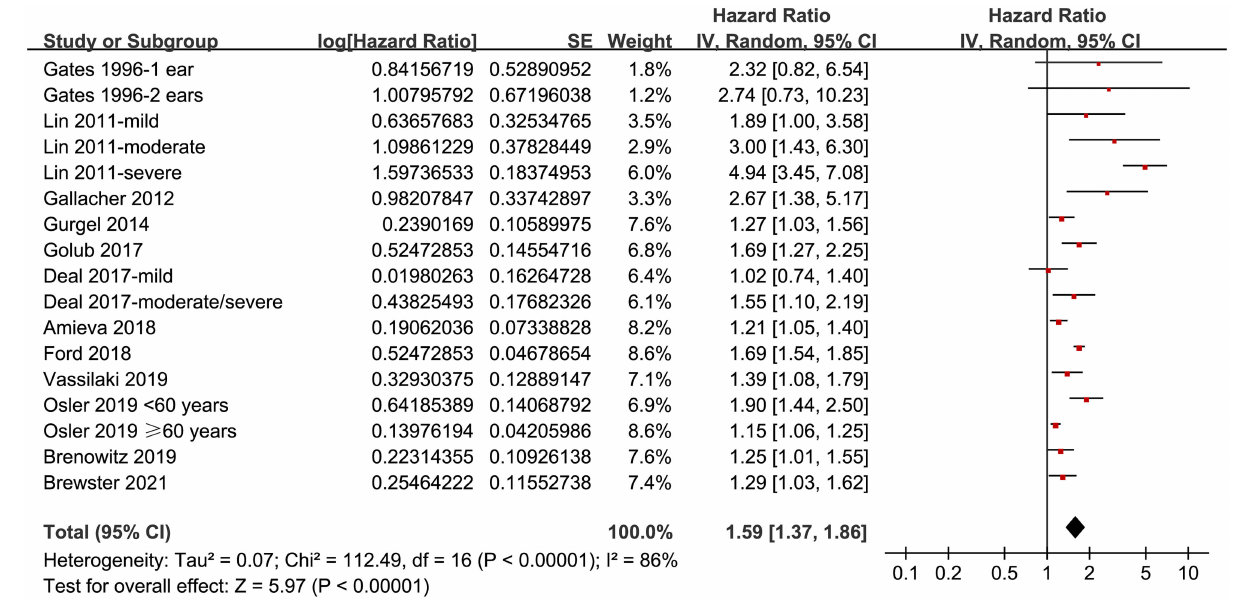
Frontiers in Aging Neuroscience |